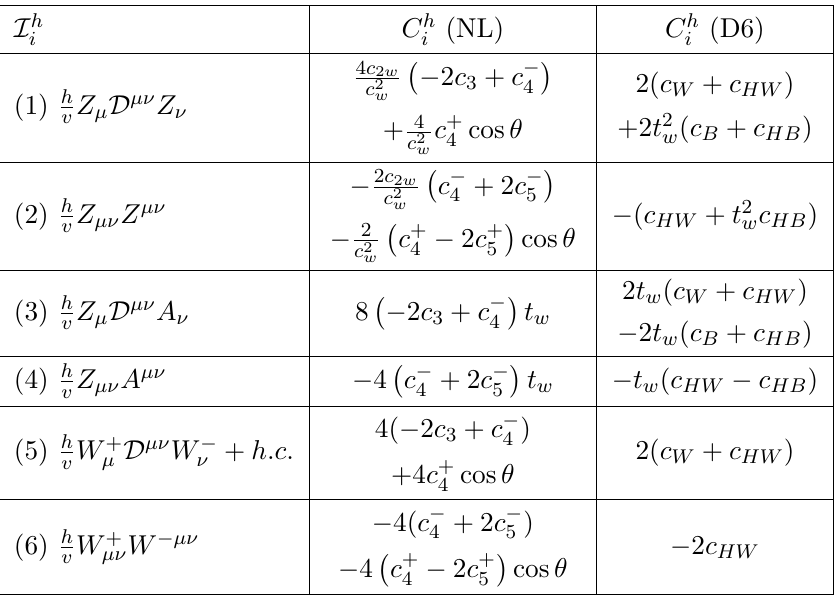
Table 1. Single Higgs coupling coe(cid:14)cients C h dimension-6 contributions (D6) in SMEFT. Here c w ; c 2 w ; t w denote cos (cid:18) W ; cos 2 (cid:18) W ; tan (cid:18) W respec- tively, where (cid:18) W is the weak mixing angle.